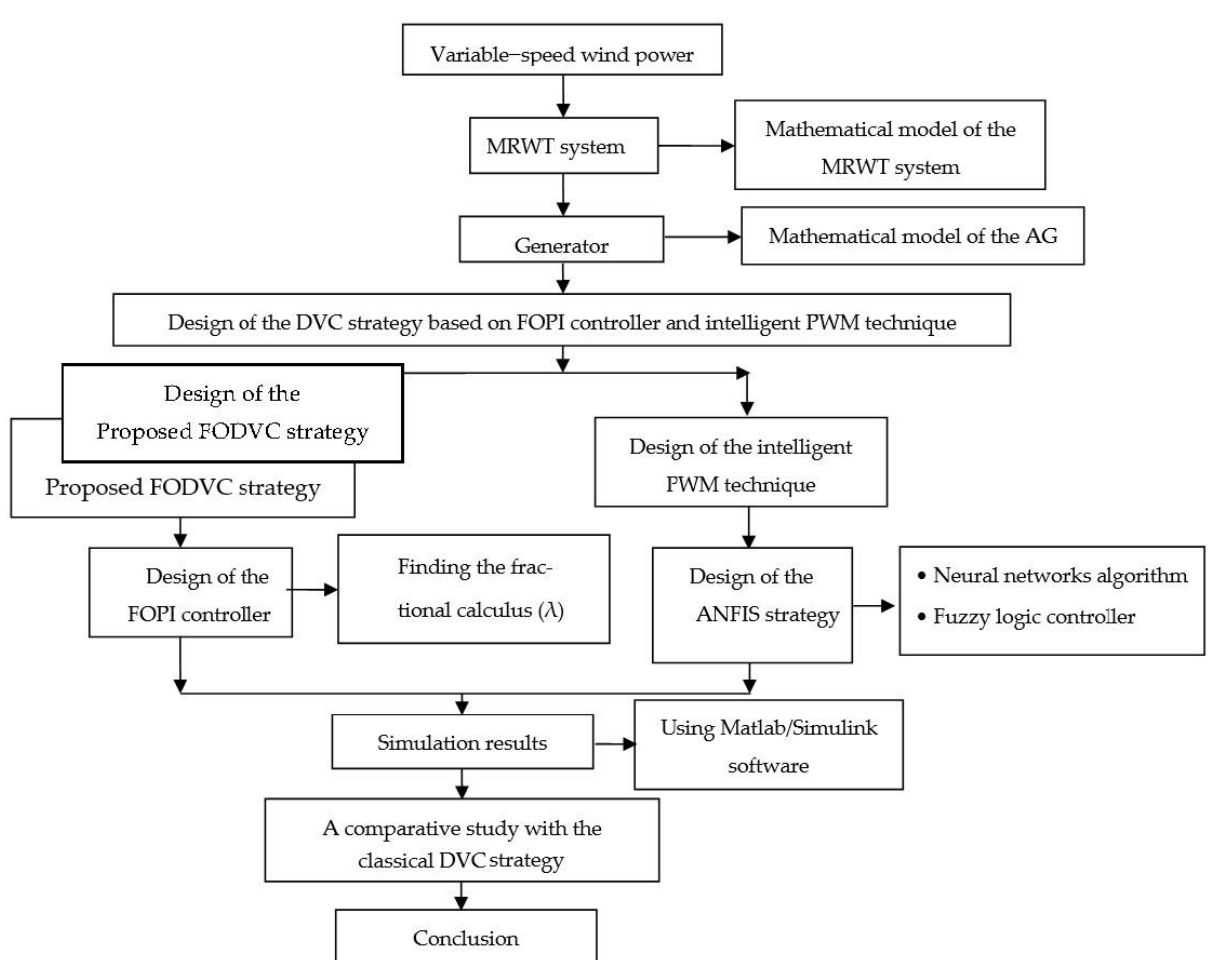
Figure 1. Diagram for proposed DVC strategy.